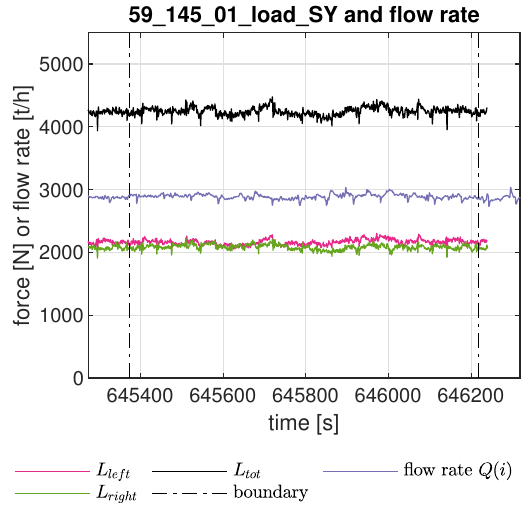
and mean angle µ δ are tot